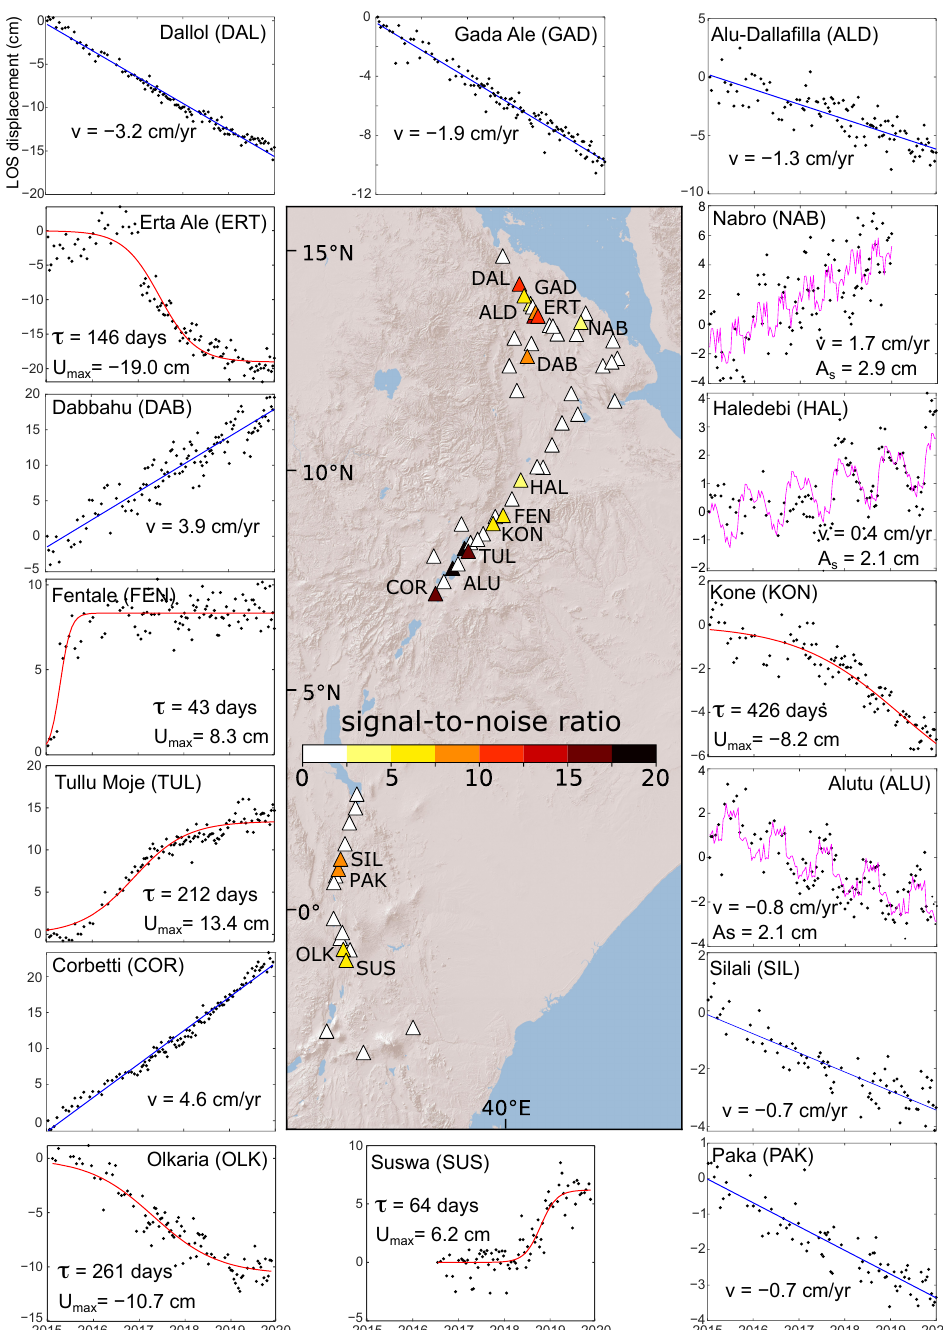
Figure 9. Map showing the ratio between the amplitude of the cumulative displacements and the temporal noise for the 64 EARS volcanoes analysed. Deformation signals are automatically detected for 16 volcanoes having a ratio exceeding 3 (colour triangles). Small panels show individual time series of LOS displacements for each deformed volcano in which temporal evolution is fitted either by linear (blue), sigmoid (red) or seasonal (pink)